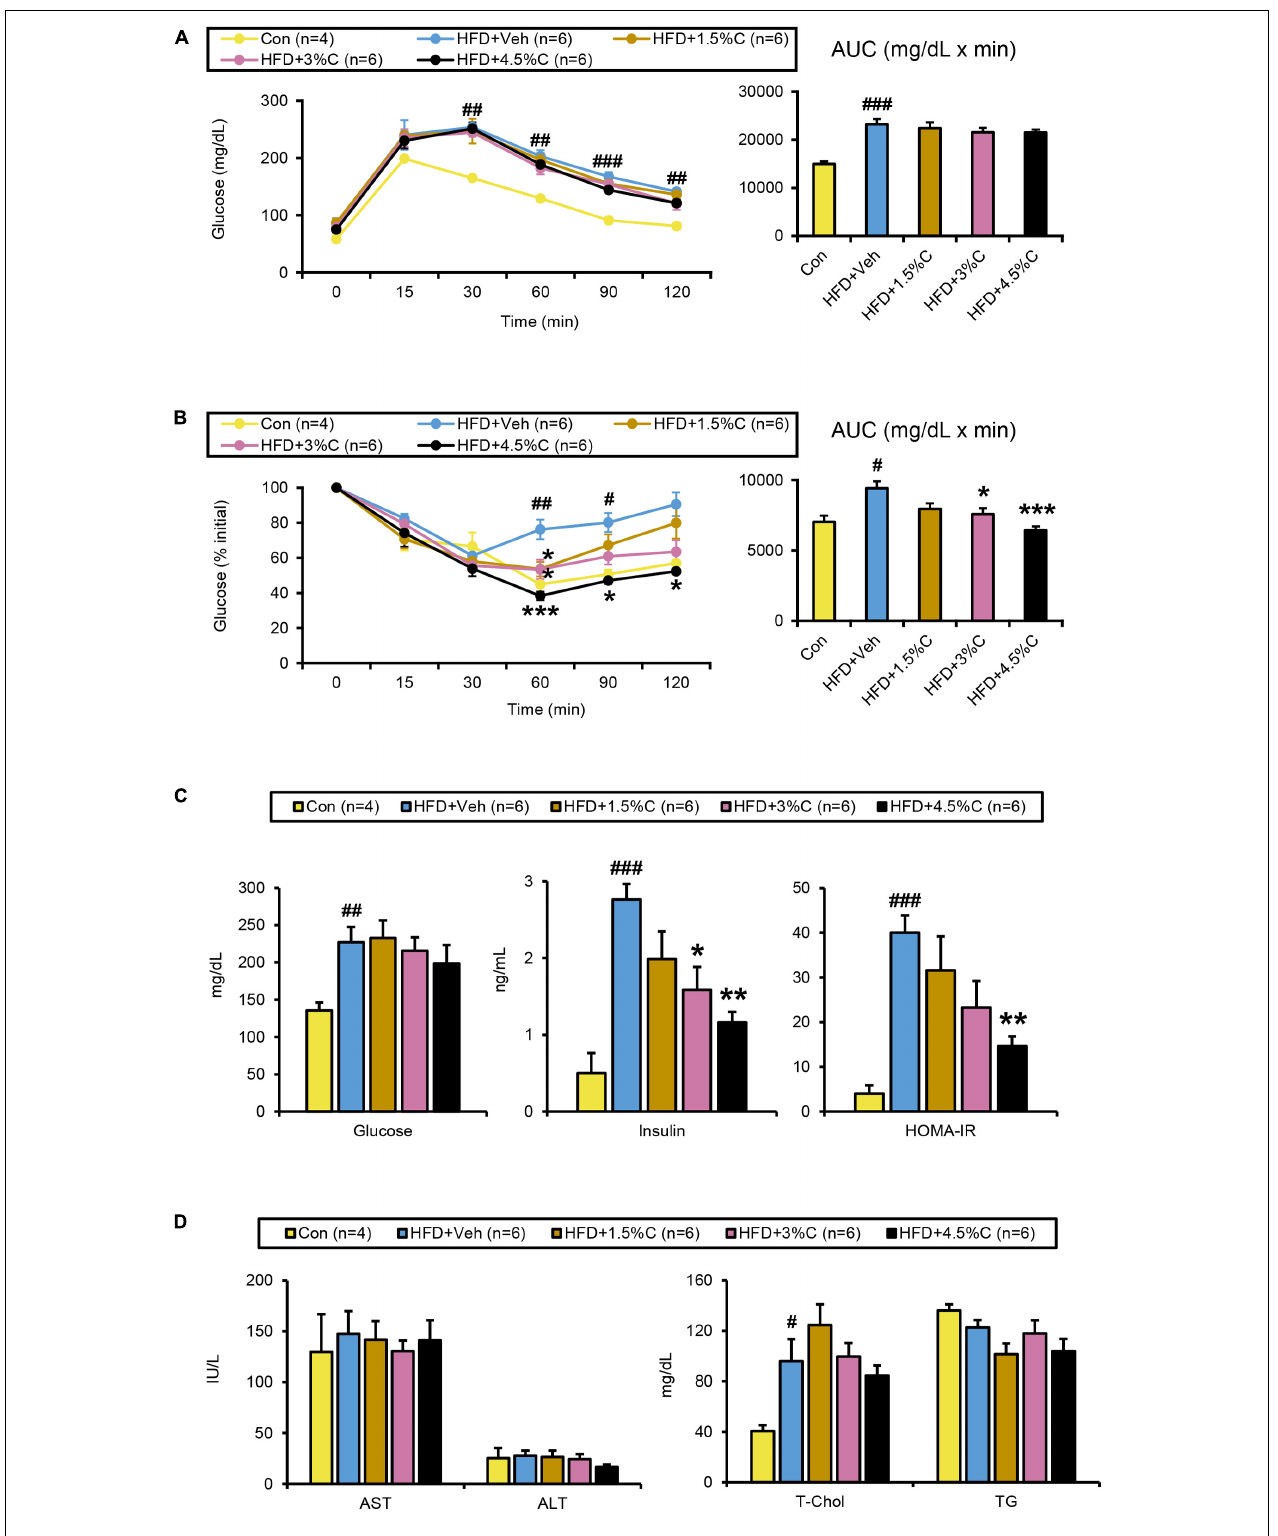
FIGURE 7 | Changes in metabolic parameters of mice treated with different dosages of acidic activated charcoal. (A) GTT at 9 weeks of HFD feeding. (B) ITT at 11 weeks of HFD feeding. (C) Serum levels of glucose, insulin and HOMA-IR. (D) Serum levels of AST, ALT, T-Chol, and TG. Data are expressed as the mean ± SEM. Statistical analysis was performed using a one-way analysis of variance (ANOVA) with the Bonferroni’s correction. * P < 0.05, ** P < 0.01, and *** P < 0.001 between the HFD + Veh group and the HFD + C group. # P < 0.05, ## P < 0.01, and ### P < 0.001 between the HFD + Veh group and the Con group.